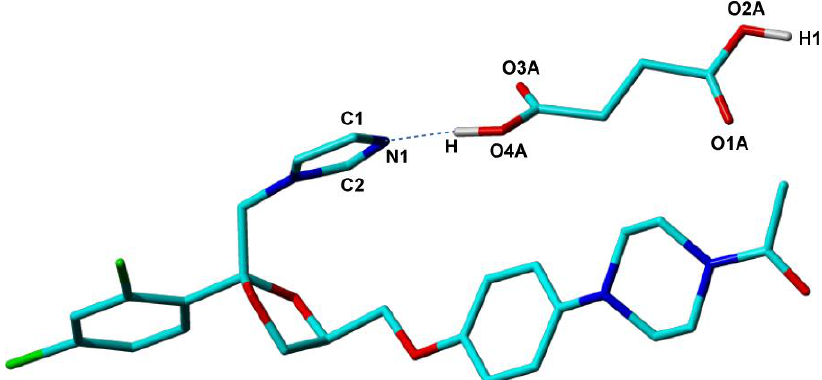
Figure 6. The O4A-H … N1 hydrogen bond between ketoconazole and succinic acid molecules in crystalline structure of the formed cocrystal.